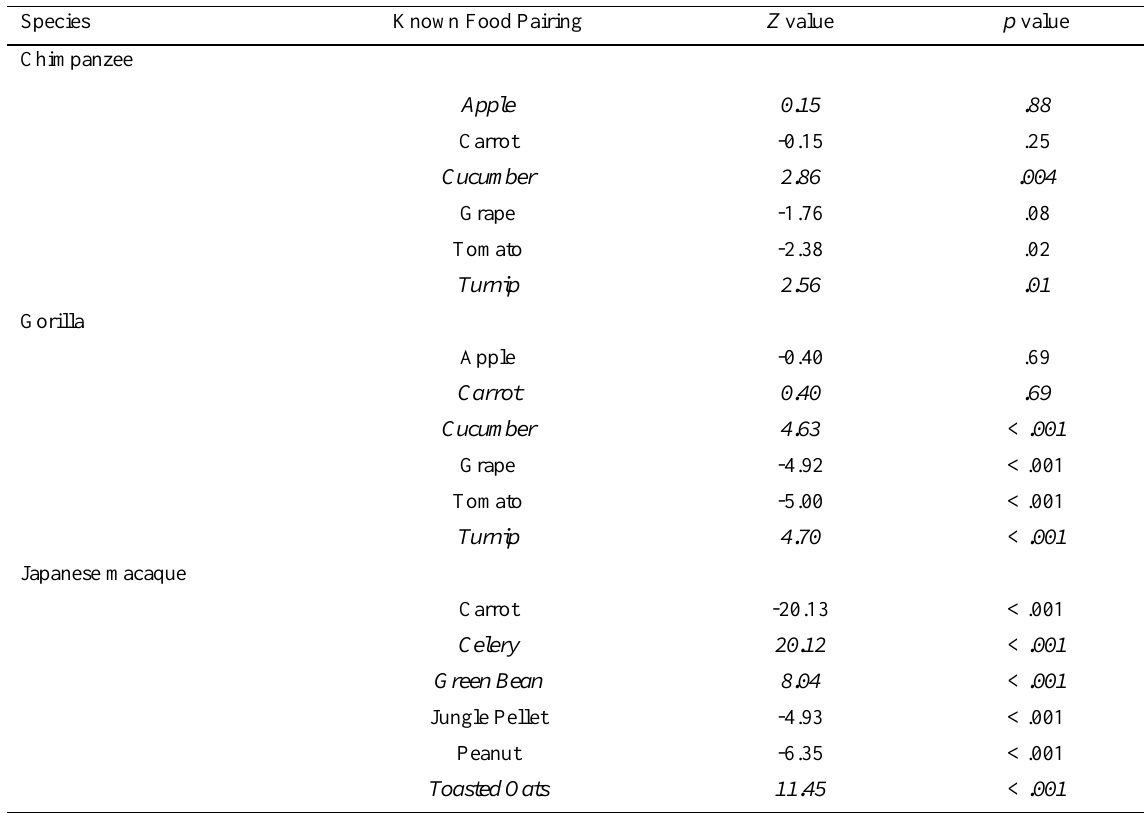
Each Species’ Likelihood to Select the Chance Symbol over a Known Food Option Across Each of the Known Food Pairings Species Known Food Pairing Z value p value Chimpanzee